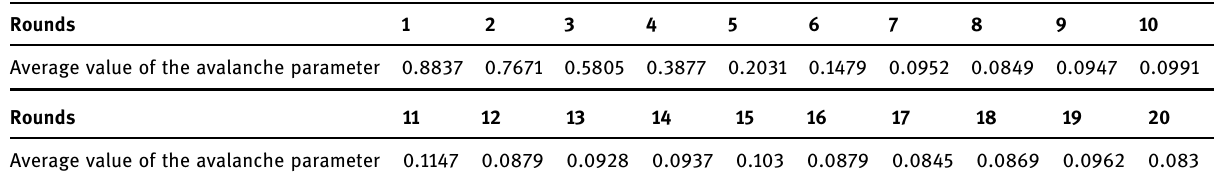
Table 5: Results of the study of the avalanche e ff ect by rounds Rounds